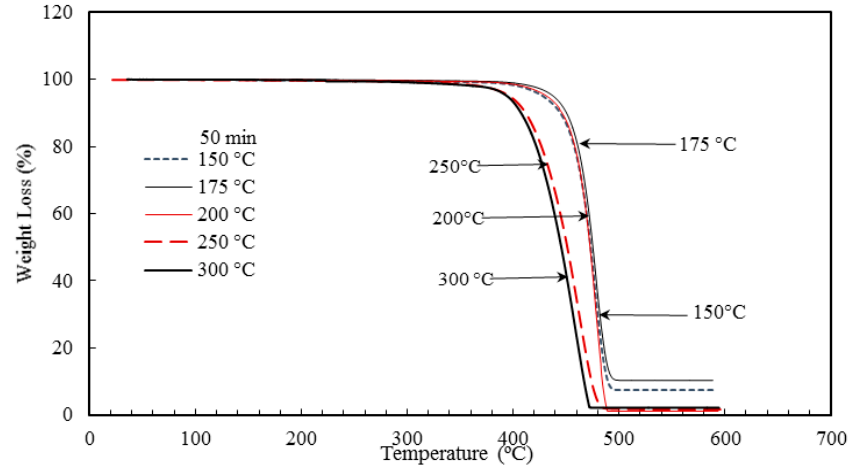
Figure 15. Thermogravimetric analysis (TGA) thermograms of HDPE/TiO 2 nanocomposites with varying barrel temperature.